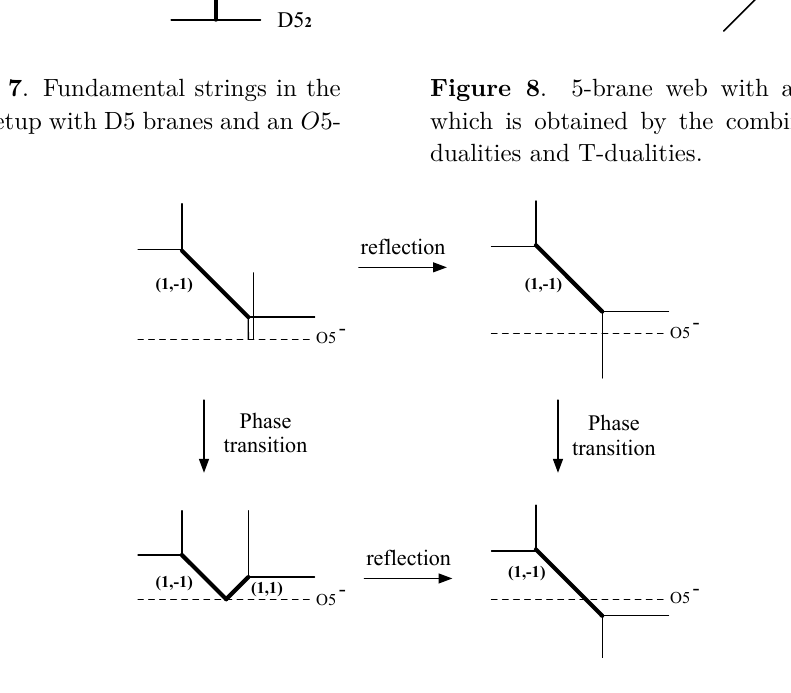
Figure 9 . The phase transition found in [19]. It can be understood naturally by partially reflecting the 5-brane web diagram. The (1 , − 1) 5-brane given by the thick line in the upper left diagram is mapped to the thick lines in the other diagrams by the reflection or by the phase